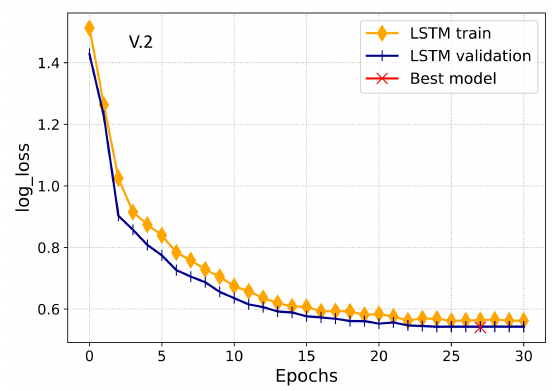
Figure 13. LSTM-based convergence analysis during